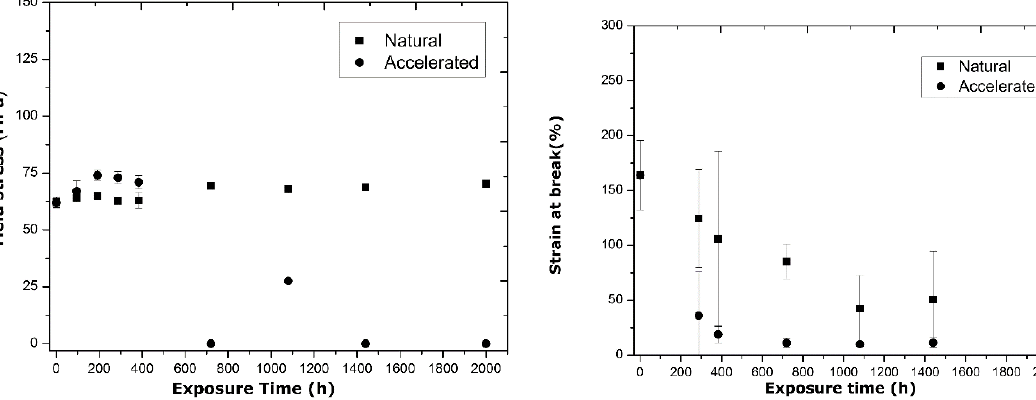
Figure 6. The yield stress as a function exposure time for natural and accelerated photoaging.